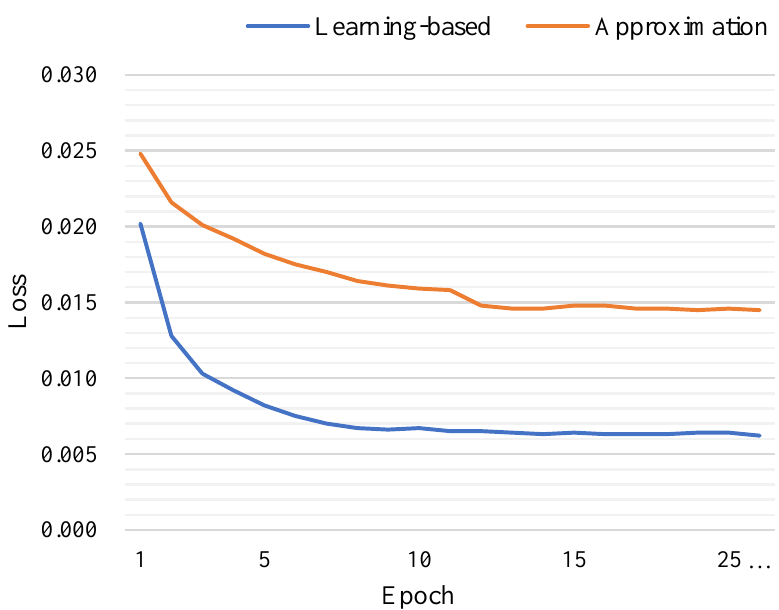
Figure 9. Loss curves during the training phase, where the blue and red curves correspond to the learning-based solution and the approximation-based solution, respectively. Obviously, the former had a low cost and fast